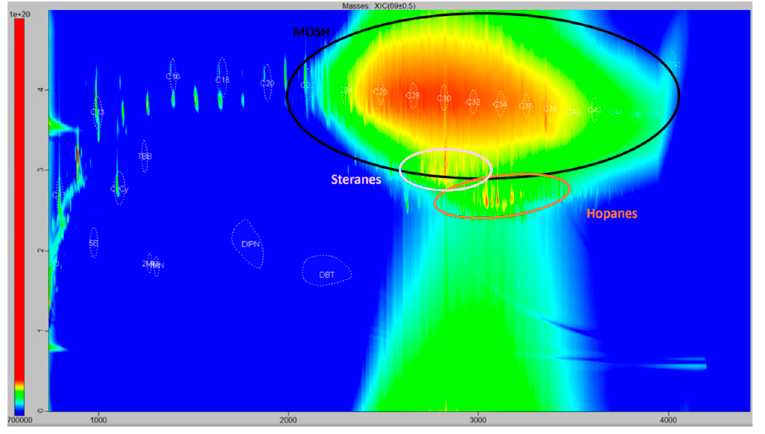
Figure 2. Extracted ion chromatogram of the MOSH fraction of an olive pomace oil sample, obtained by HPLC-GCxGC-TOF/MS, corresponding to m/z 69.